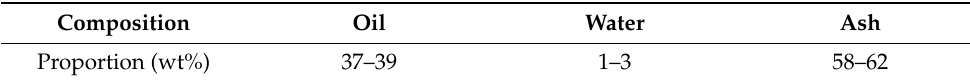
Figure 2. Thermogravimetric analysis of stainless steel sludge. Table 1. Proportions of stainless steel sludge by weight.